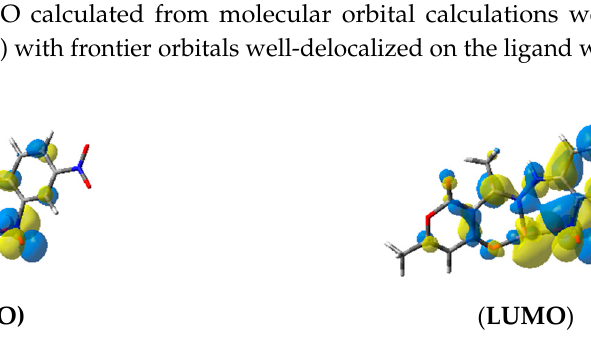
Table 1. Molar extinction coefficients ε in different solvents for the cu-complex investigated.